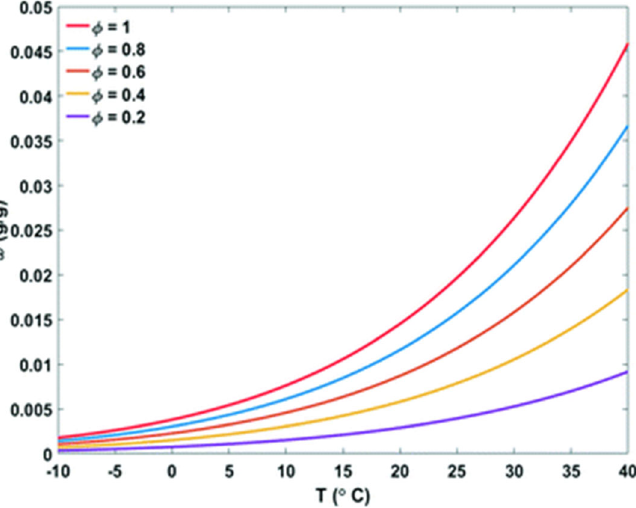
Figure 6. Relative and absolute humidity in the air depends on temperature (T). Saturated air is created by either reducing the temperature or raising the absolute humidity level in unsaturated air